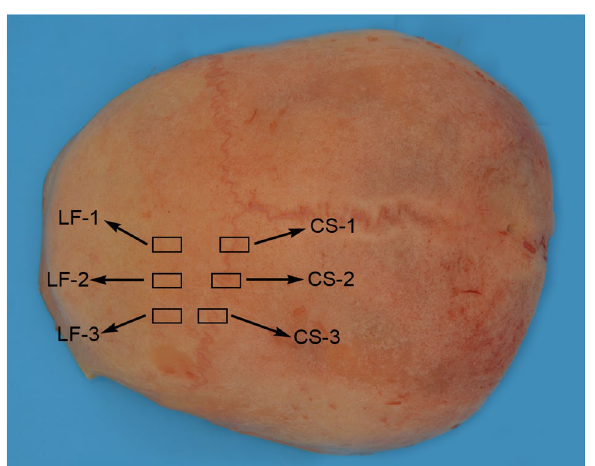
Figure 1. Material drawing of each part of the